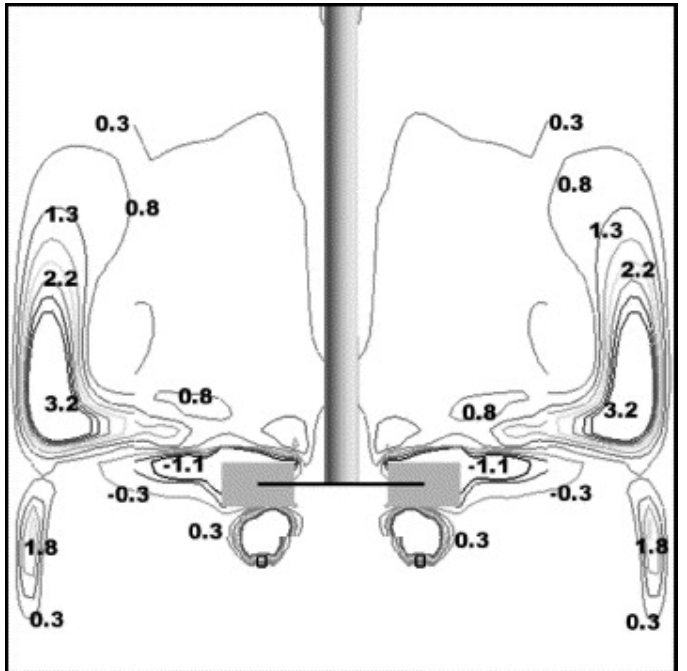
Figure 6. CFD predicted net attachment rates (108 m − 3 s − 1 ) after flotation time of 320 s for particles of 60 μ m diameter in the stirred cell [87] .